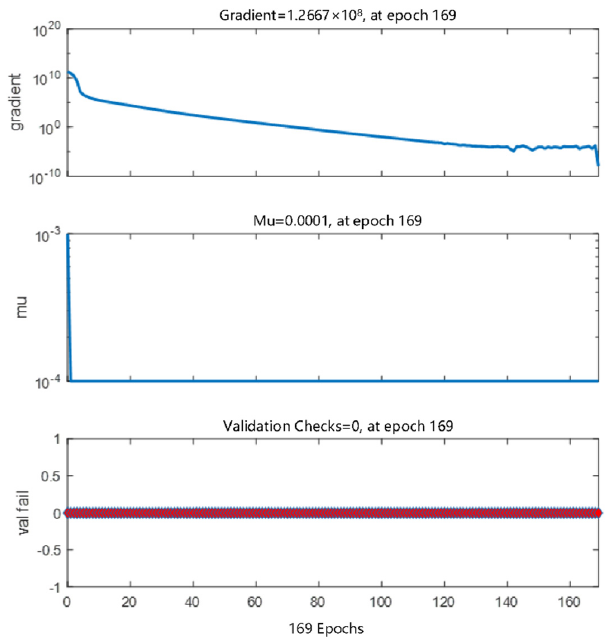
Figure A3. The training status diagram of the BP neural network.